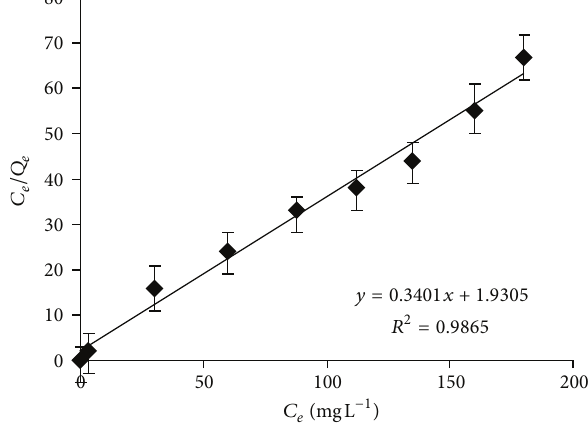
Figure 6: Langmuir isotherm plot for the adsorption of Cr(VI) into the micelle-clay complex. Contact time = 3 h, temperature = 25.0 ± 0.2 ∘ C, and adsorbent dosage = 5.0 gL −1 . Data represent averages of Cr(VI) triplicate measurements (UV-vis) ± SE.